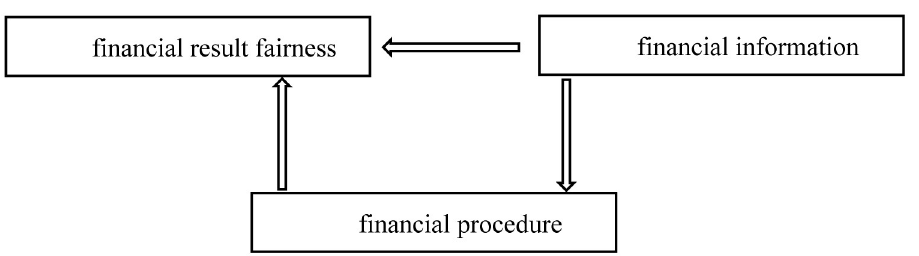
Fig 4. The relationship of three dimensions of financial